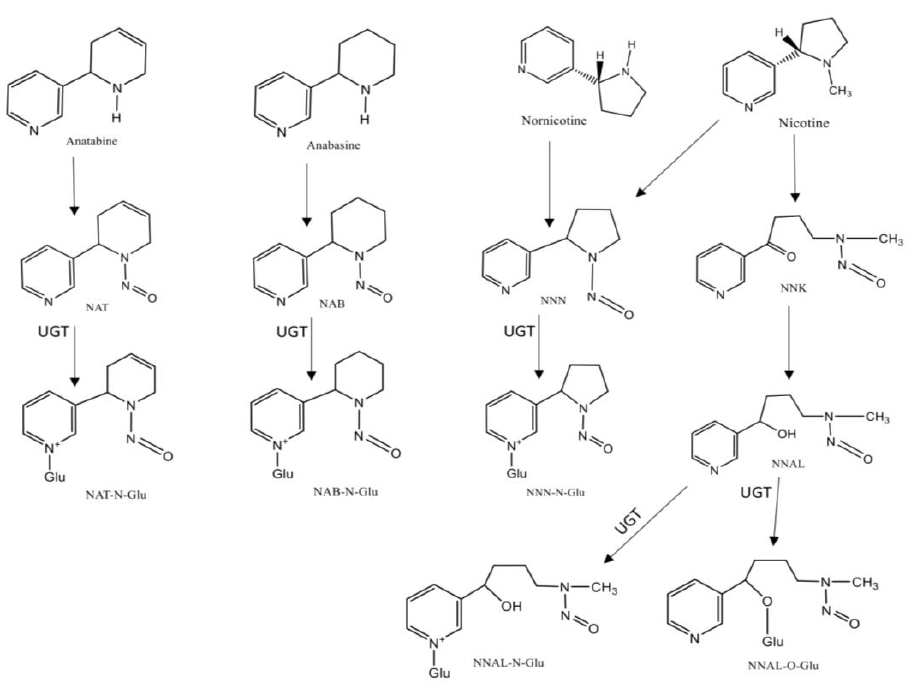
Figure 2. Chemical structures and metabolism of Tobacco-Specific N-Nitrosamines (TSNA). Legend: